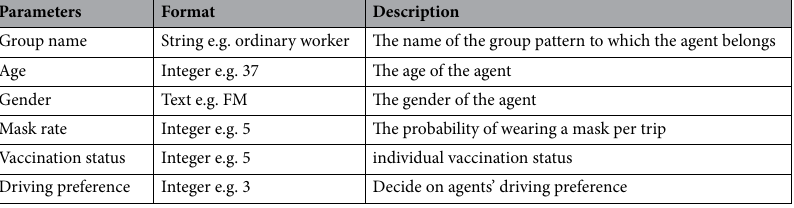
Table 2. Parameters of the agent.